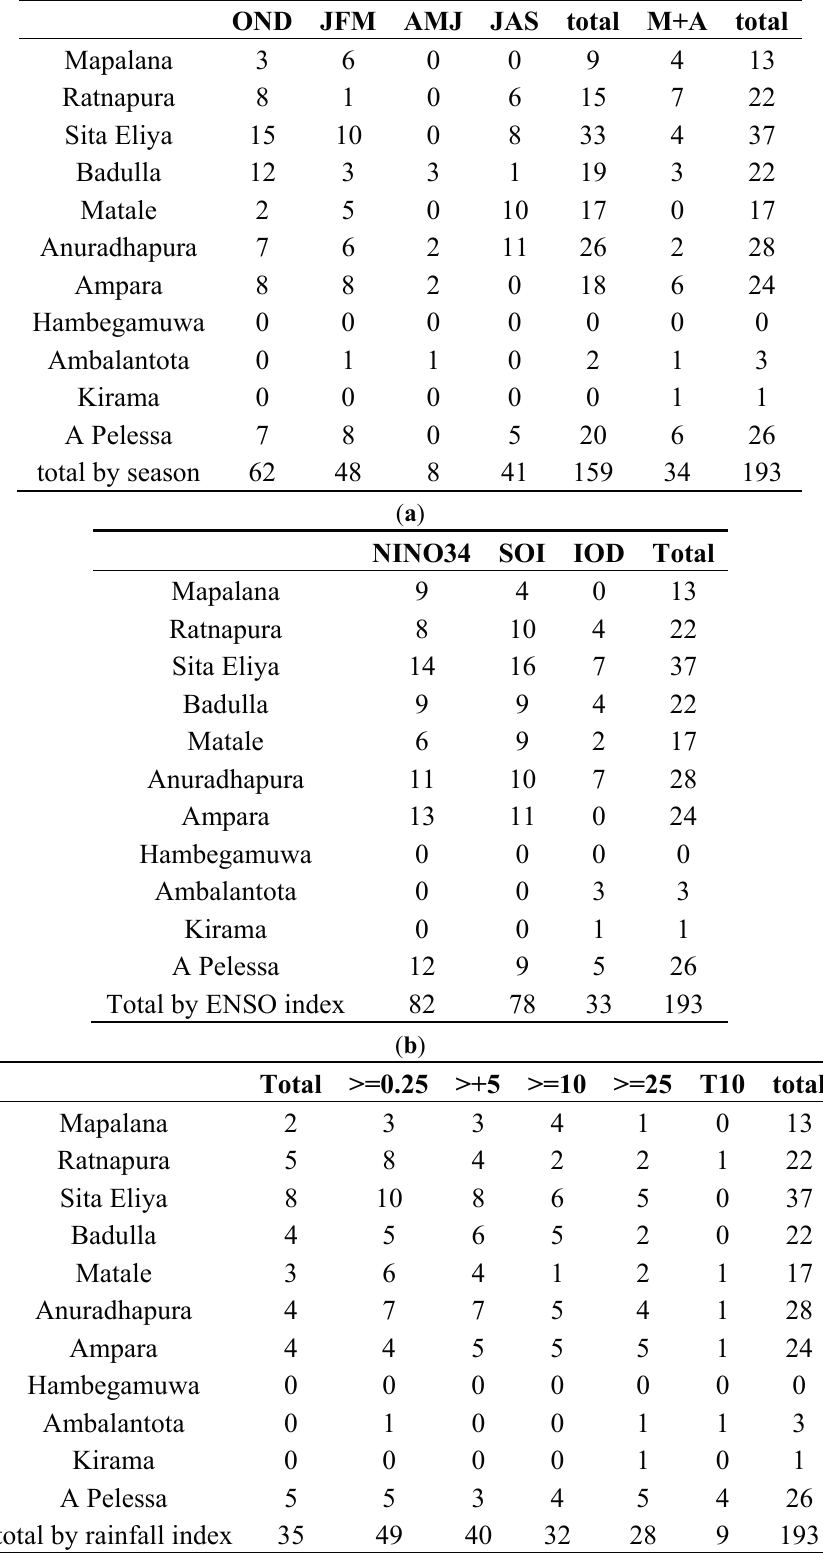
Table 3. Summary of significant correlations between rainfall stations and ocean-atmosphere drivers: ( a ) total number of significant correlations by season, plus M+A; ( b ) correlations with different climatic indices; ( c ) correlations with different rainfall indices, seasonal total plus number of days above a given